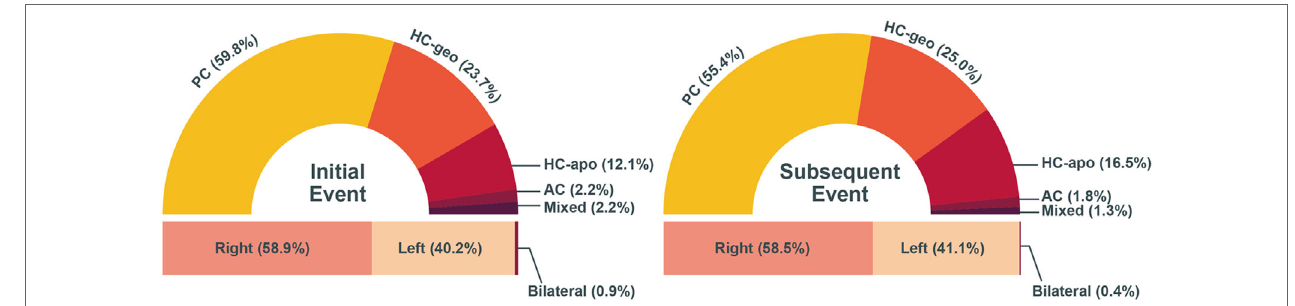
FigUre 1 | The proportion of involved canal and ear during the initial and subsequent events. There was no difference in the proportion of involved canal and affected side between the events (Chi-square test, p > 0.05). AC, anterior canal; HC-apo, apogeotropic horizontal canal; HC-geo, geotropic horizontal canal; PC, posterior